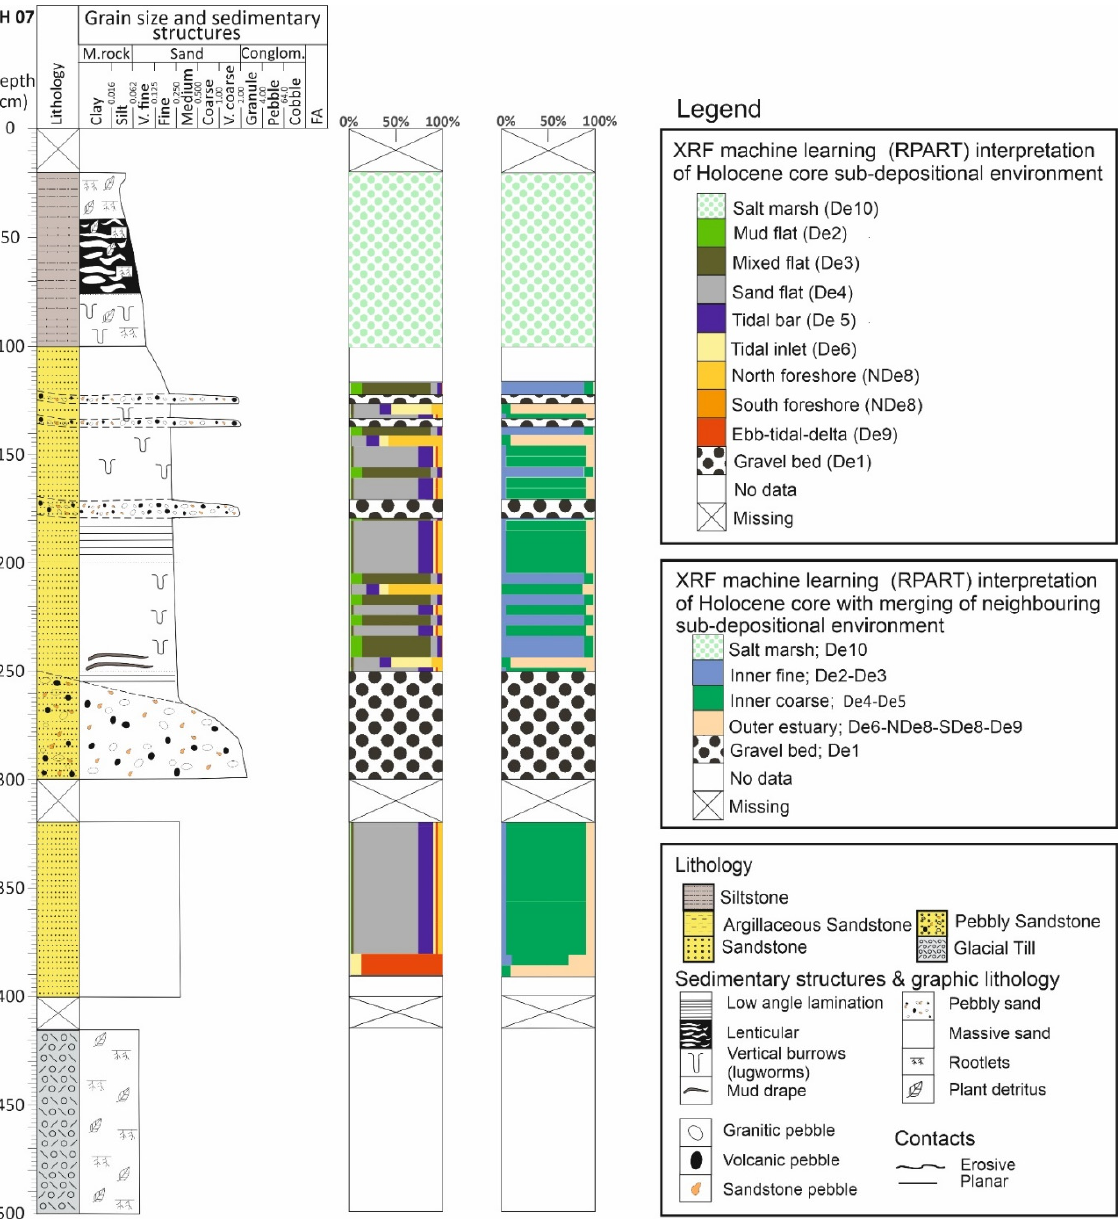
Figure 12. Schematic sedimentary log of the cored sediment beneath inner estuary vegetated tidal bar deposits (see Figure 1 for core location) with application of the classification tree in Figure 9 (wholly split sub-depositional environments) and Figure 11 (partly merged sub-depositional environments) to data presented in Figure 8. The split and merged geochemical classification models reveal a succession of sub-depositional environments that could not easily be predicted based only on classical core description